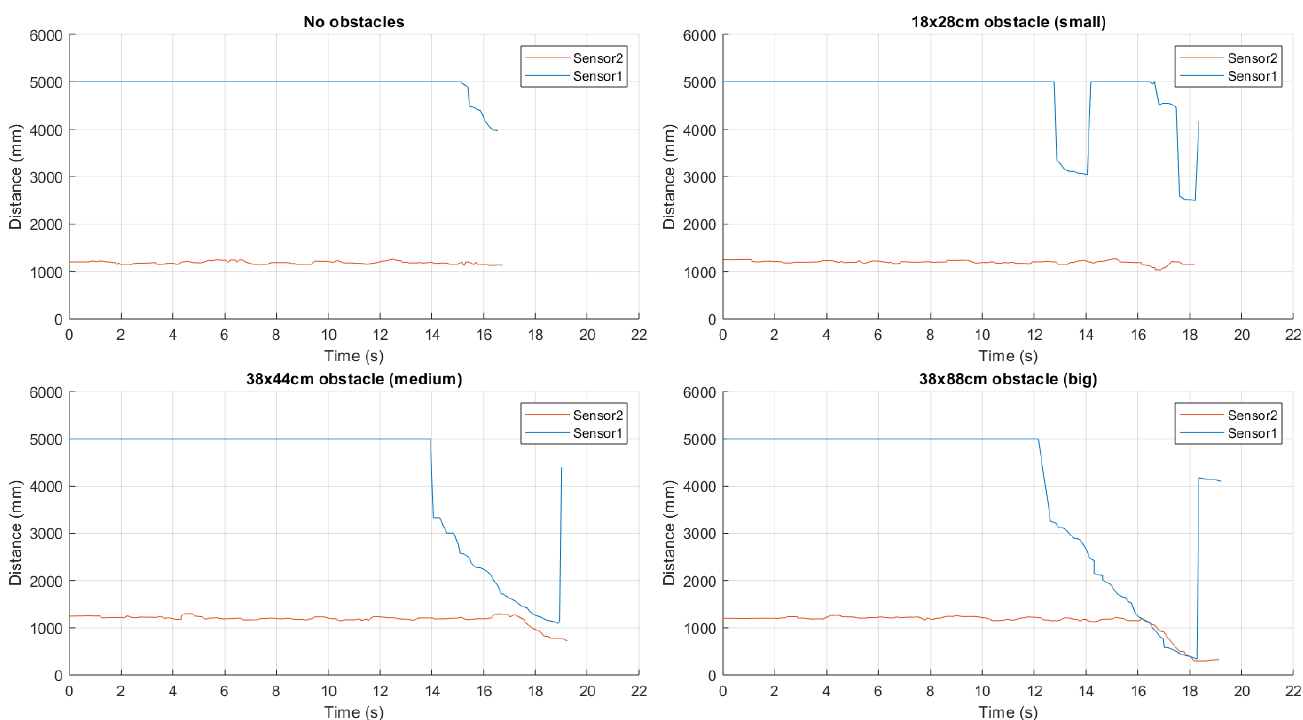
Figure 16. Distances detected with the configuration with two adjacent ultrasonic sensors, the top one pointing forward and the bottom one tilted down with a “medium”